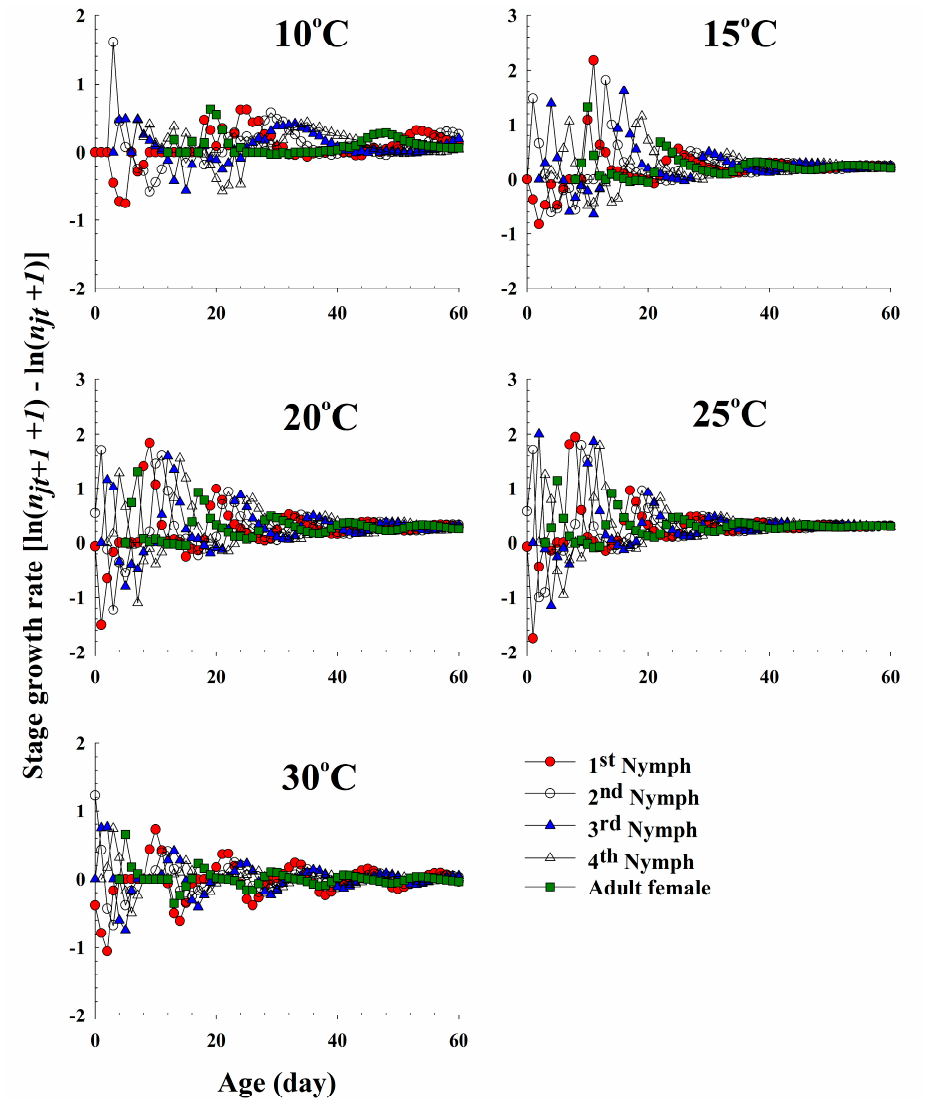
Figure 7. The stage growth rate of Acyrthosiphon pisum in response to different temperature conditions.